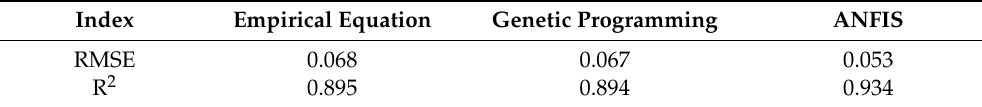
Figure 5. Comparison of observations with predictions obtained by three different methods: empirical equations, genetic programming, and the ANFIS model. Table 2. Performance indices for the predictions obtained by three different methods: empirical equations, genetic programming, and the ANFIS